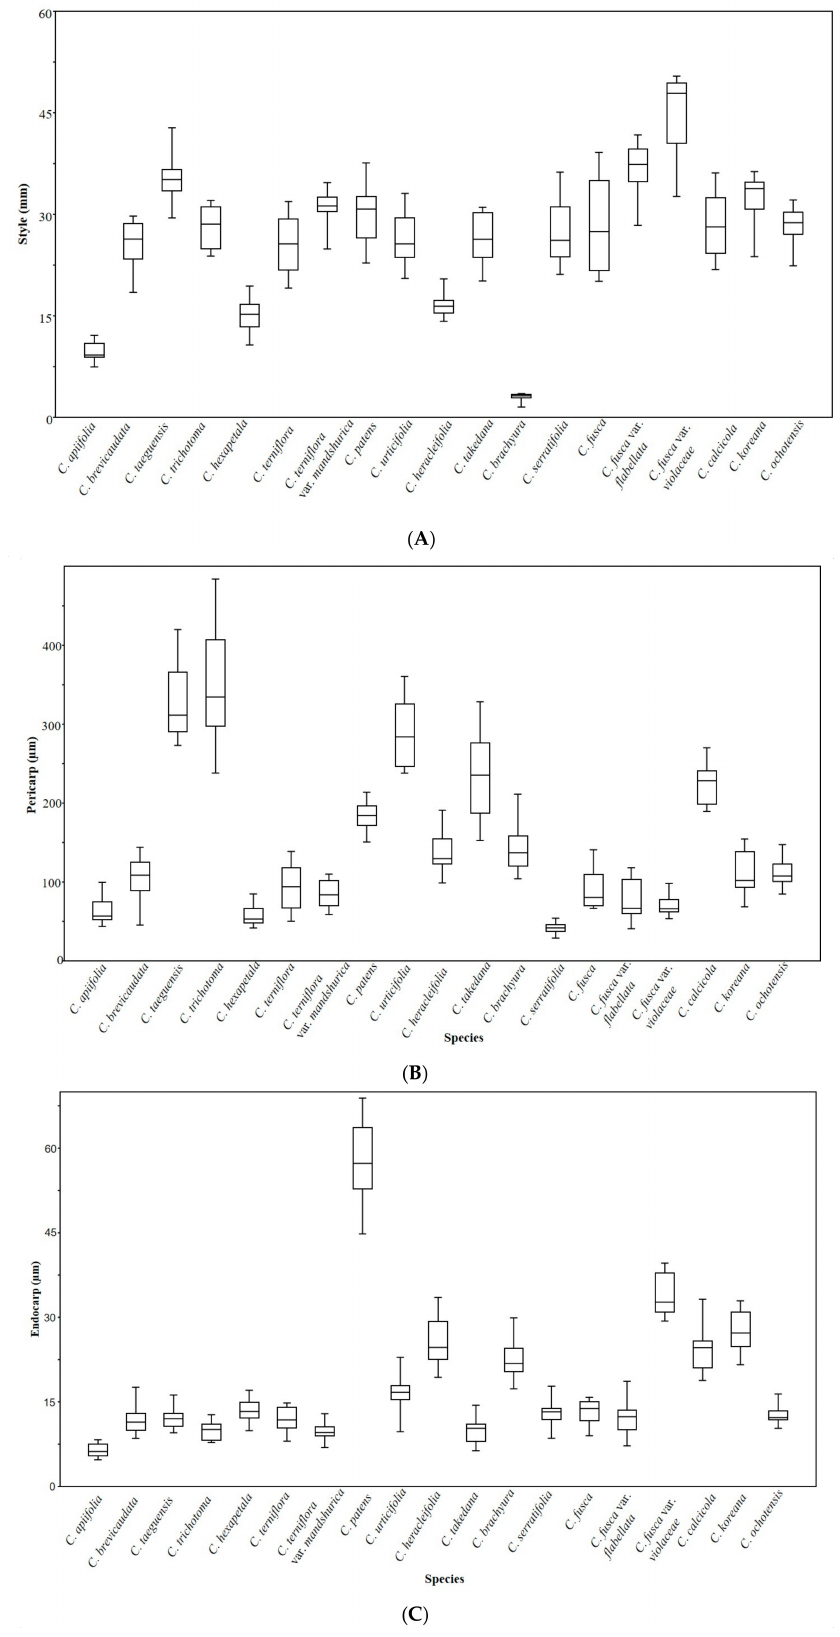
Figure 8. Normal boxplot showing style length, pericarp, and endocarp thickness of Clematis achene. ( A ) Style. ( B ) Pericarp. ( C )